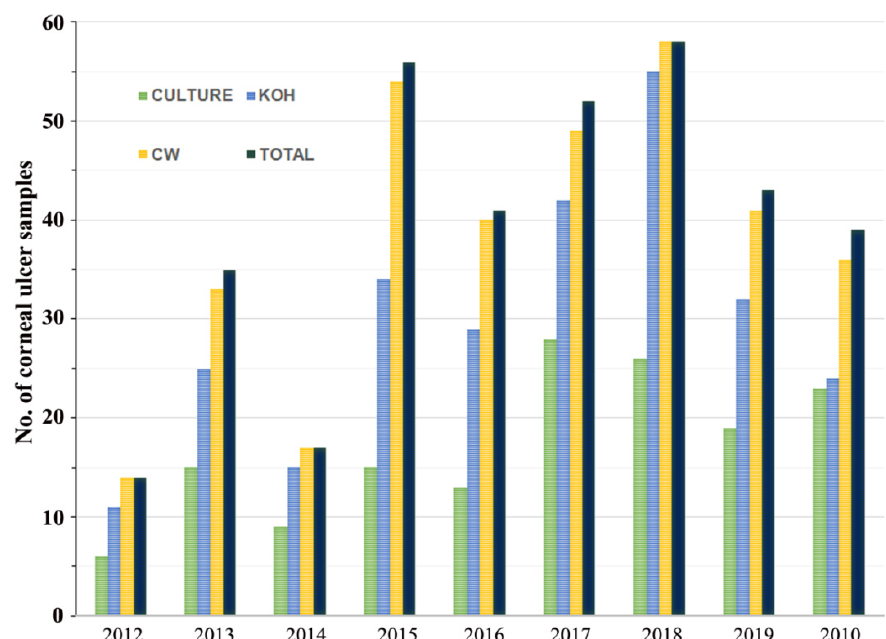
Figure 2. Comparative study of positive results for Calcofluor white (CW), KOH wet mount, and culture-proven disease relative to total cases of fungal keratitis identified.